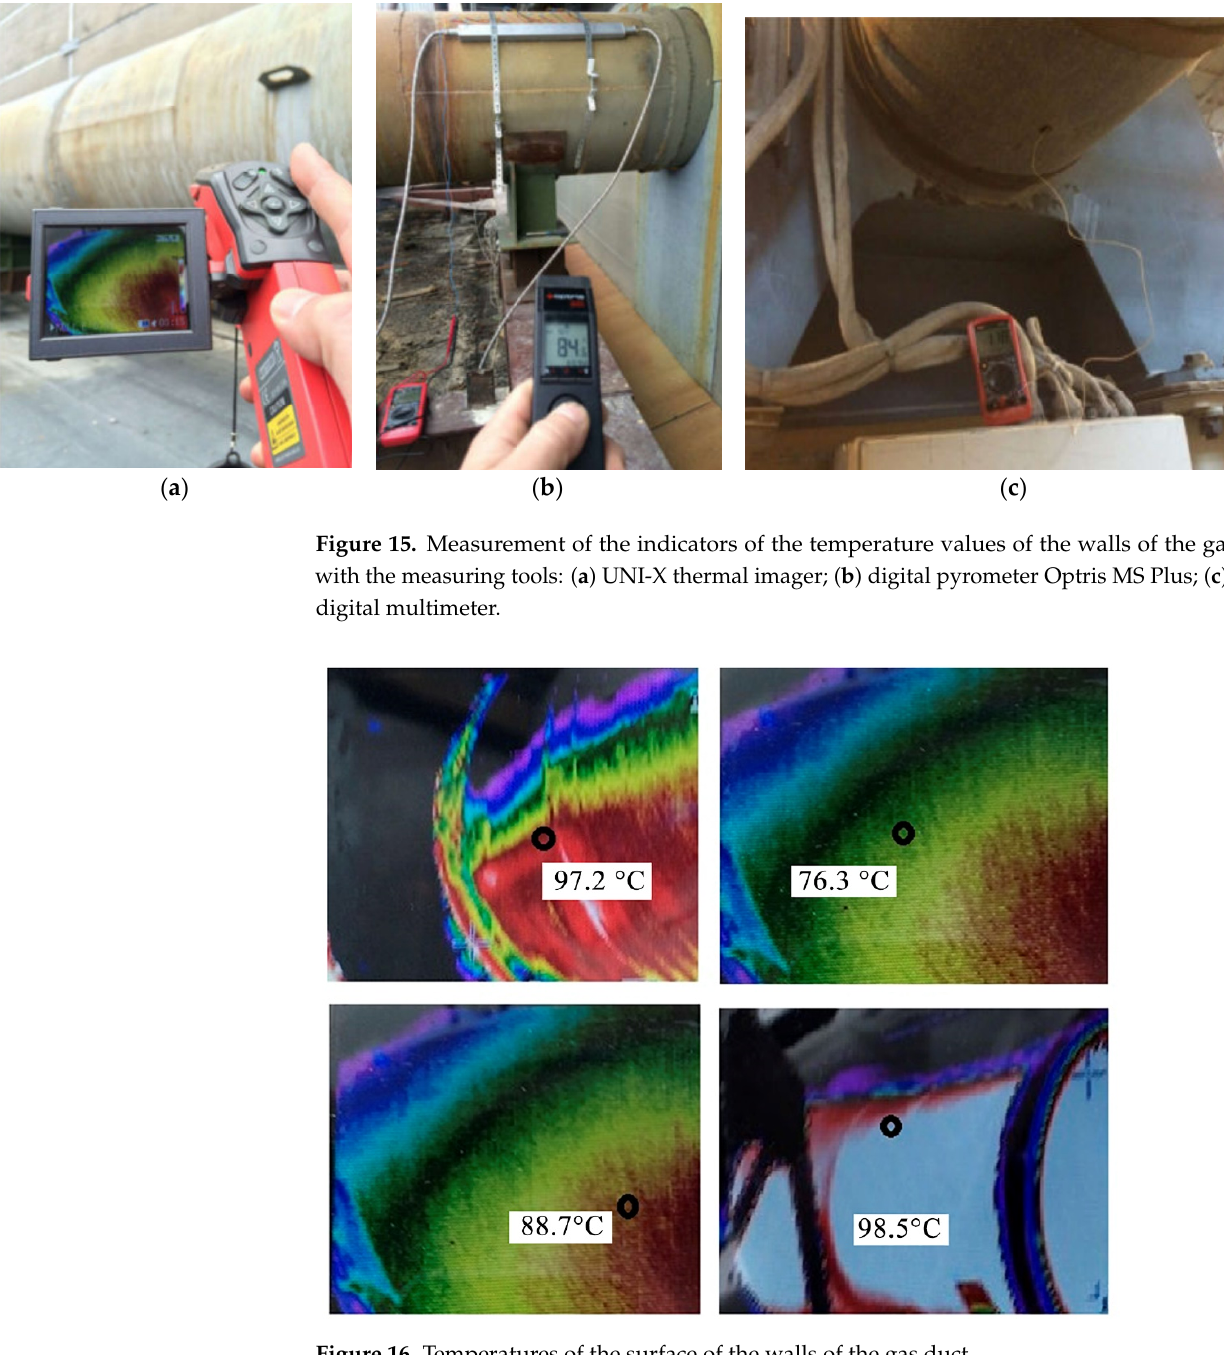
Figure 17. Unit of the thermoelectric converter of the gas cooling module. The unit of the thermoelectric converter was fixed to the gas duct using perforated fastening tape, enabling the possibility of tightening (Figure 18). As a source of water sup-